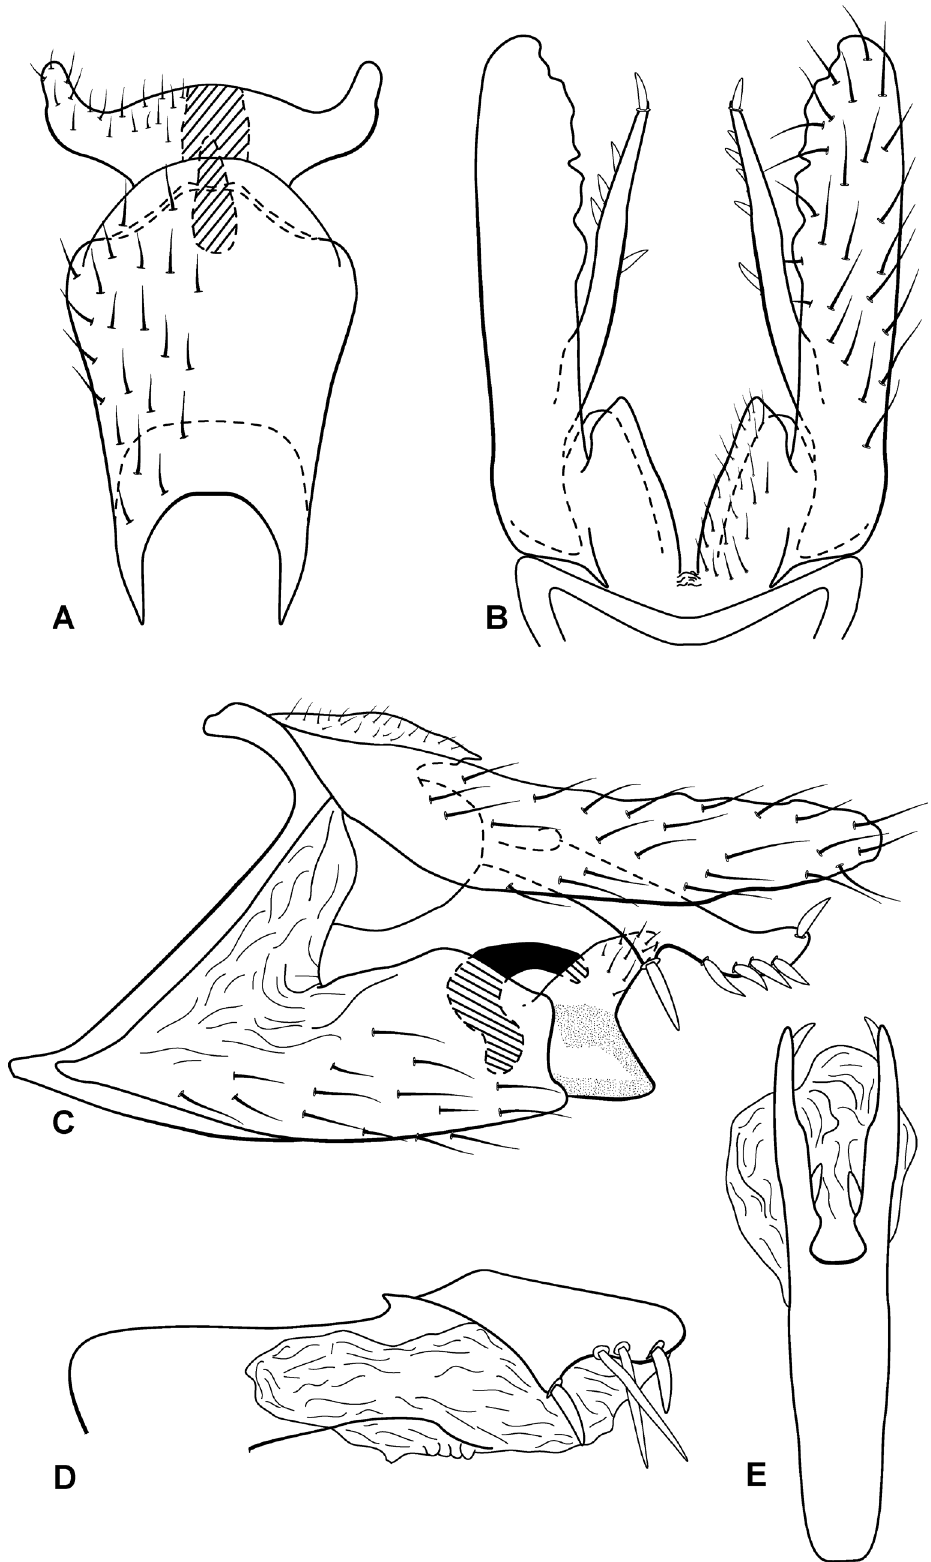
Fig. 2. Austrotinodes adolfolutzi sp. nov., male genitalia. A . Ventral view. B . Dorsal view. C . Left lateral view. D . Phallic apparatus, left lateral view. E . Phallic apparatus, dorsal